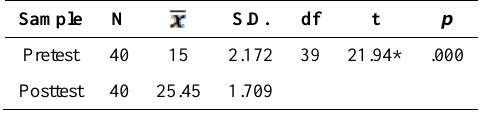
Table 4. Student ATS pre-test and post-test testing results